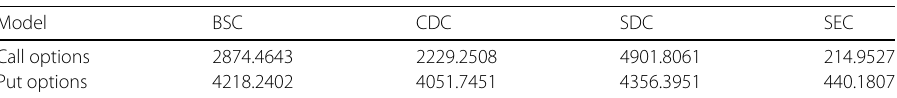
Table 4 Mean squared errors of call option prices obtained by four different models for the NASDAQ-100 option prices